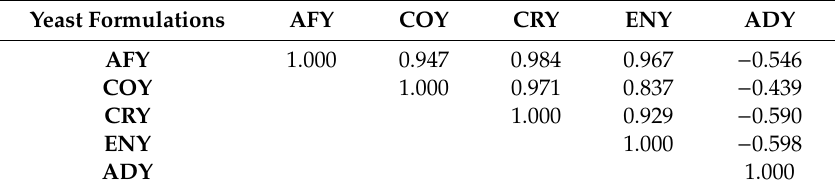
Table 1. Correlation indexes among the yeast formulations available for the winemaking and admitted by the International Organization of Vine and